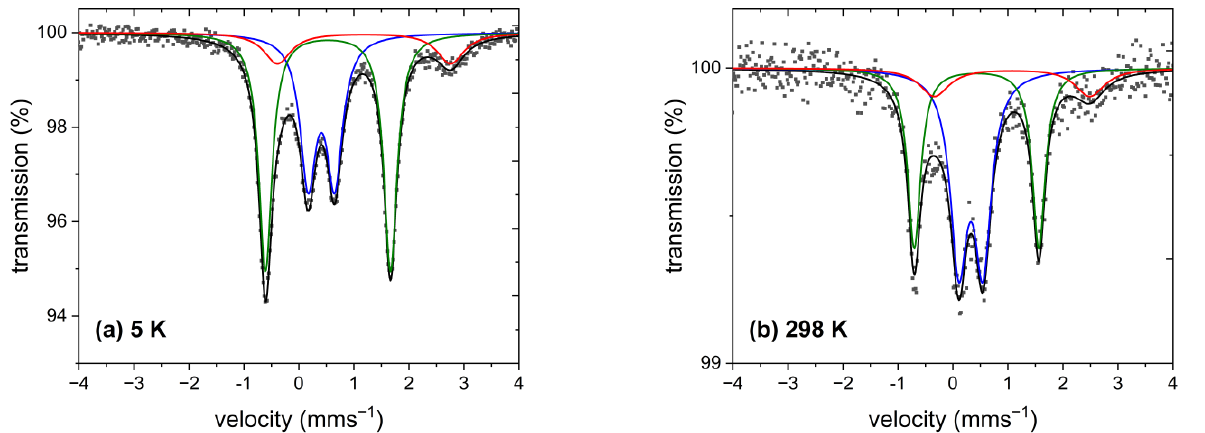
Figure 6. 57 Fe Mössbauer spectra for 1 at T = 5 ( a ) and at T = 298 K ( b ). The dots represent the experimental data, and the calculated data are shown with a full black line. The respective subspectra are colored as {Fe(abpt)} LS in blue, {Fe(abpt)} HS in red, and {Fe(Cp)} in green color. Table 2. Experimentally determined 57 Fe Mössbauer parameters for 1 and other Fe II complexes with abpt ligand a .